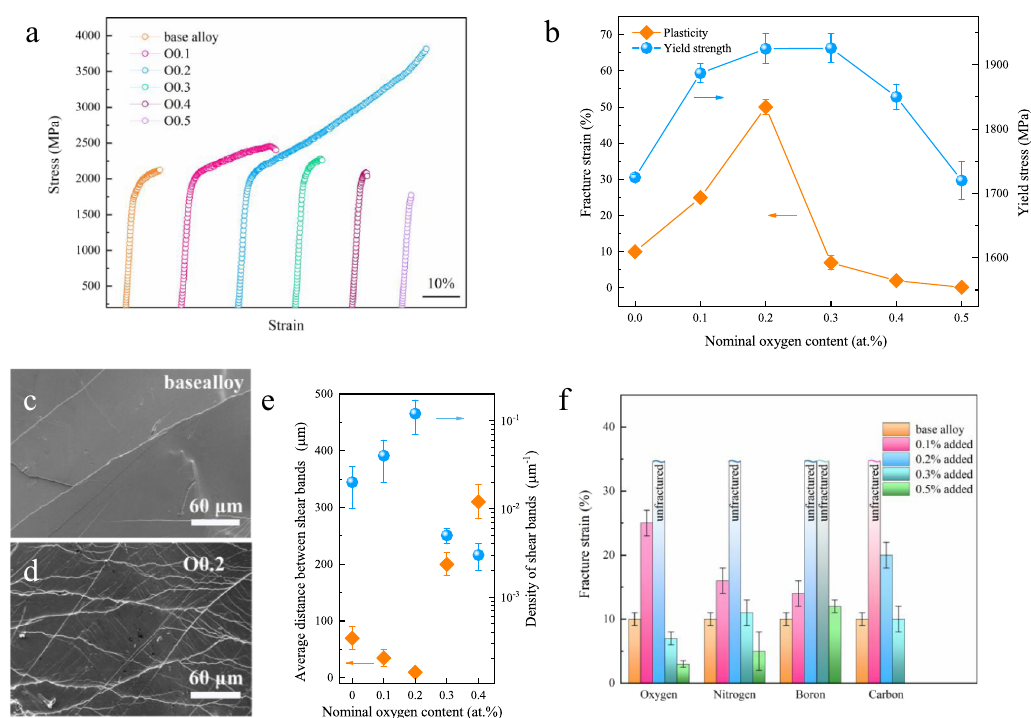
Fig. 1 Mechanical behavior of the base and doped ZrTiHfCuNi BMGs. Compressive stress-strain curves of ZrTiHfCuNi BMGs doped with a different content of oxygen ( a ). Variation of fracture strength and plasticity with addition of oxygen ( b ). Lateral surface of fractured base alloy ( c ) and O0.2 ( d ). Shear band spacing and number density in the fractured samples with a different content of oxygen ( e ). Plasticity change with doping in ZrTiHfCuNi BMGs ( f ). The error bars in b , e , f were estimated from standard deviation with a con fi dence of 95%.